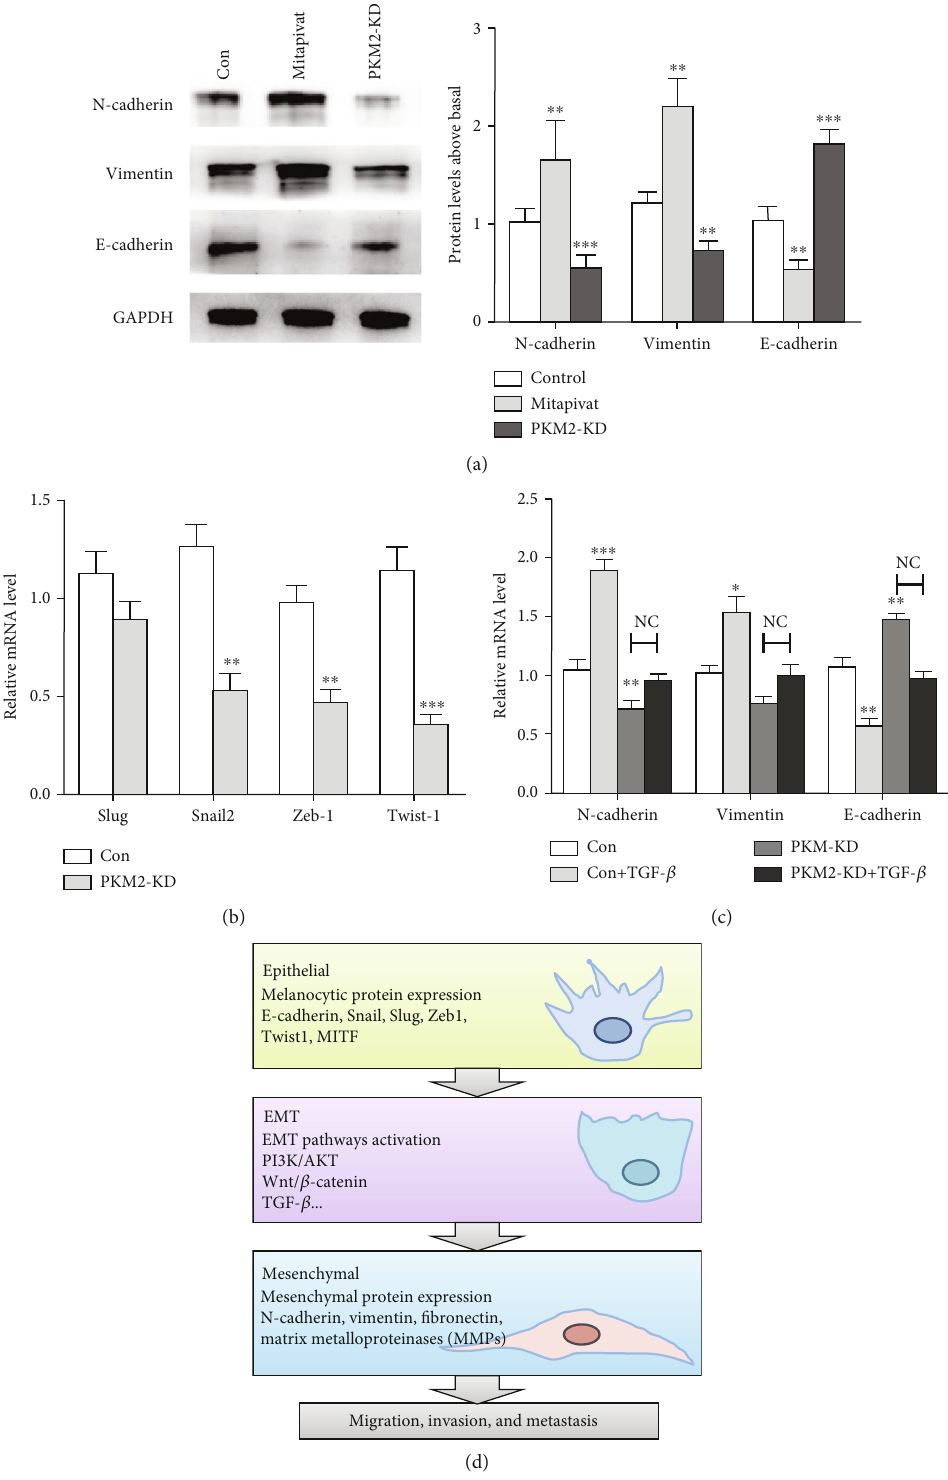
Figure 5: Silencing PKM2 suppresses MDA-MB-231 cell EMT. (a) Western blot analysis of protein levels of EMT marker proteins in control, Mitapivat, and PKM2-KD groups. GAPDH was used to normalize protein expression (left panel). The protein levels of EMT markers were quanti fi ed and compared (right panel). (b) Q-RT PCR analysis of mRNA levels of key EMT-related genes (Snail, Slug, Zeb1, and Twist1) in control and PKM2-KD cells normalized to GAPDH. (c) Relative mRNA levels of vimentin, N-cadherin, and E-cadherin after EMT induction in MDA-MB-231 cells in control and PKM2-KD cells for 48 h. (d) Changes involved in EMT ( ∗∗∗ P < 0 : 001 , ∗∗ P < 0 : 01 , NC : P > 0 : 01